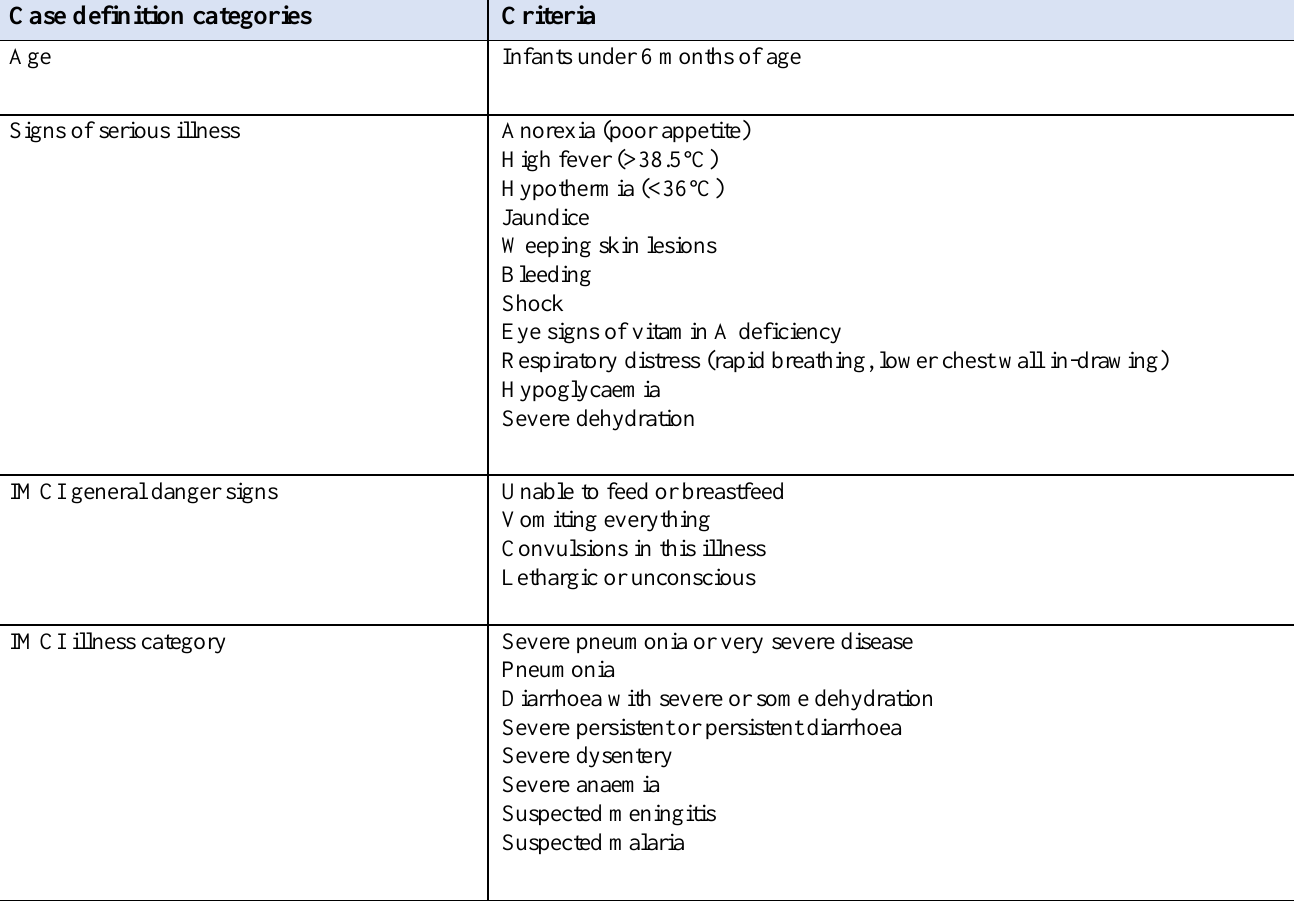
Table 2. SAM in-patient admission